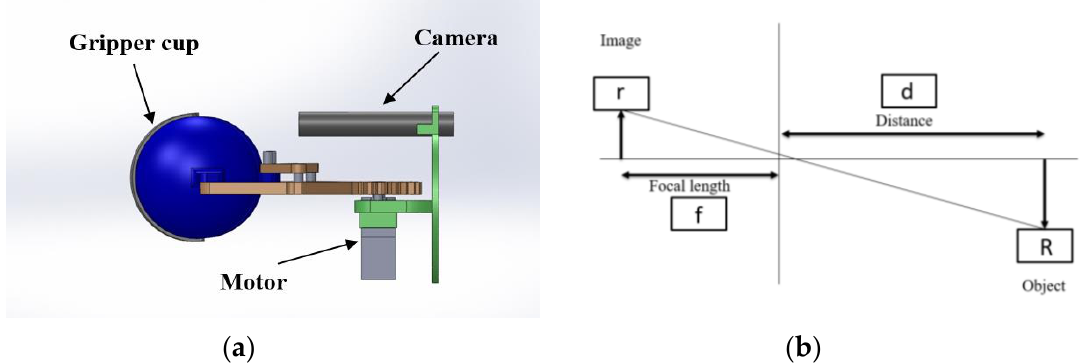
Figure 15. The gripper and camera allocation and the way to measure object location by a single camera [36]. ( a ) CAD view of gripper and camera structure. ( b ) Principal working diagram of the camera for distance measurement.